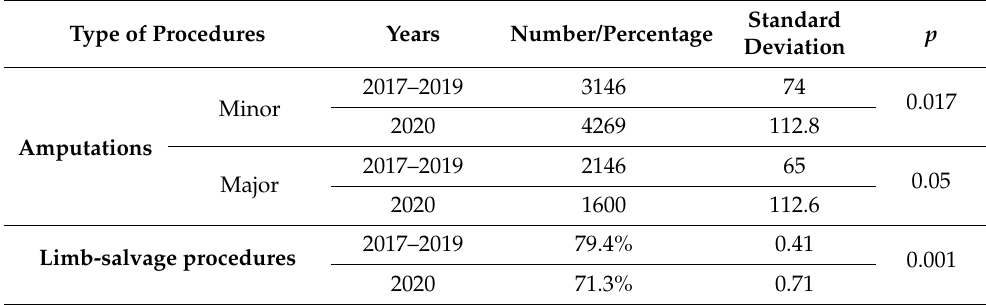
Table 3. A comparison of the percentage of procedures among patients with DFU in 2017–2019 (combined and averaged data) and